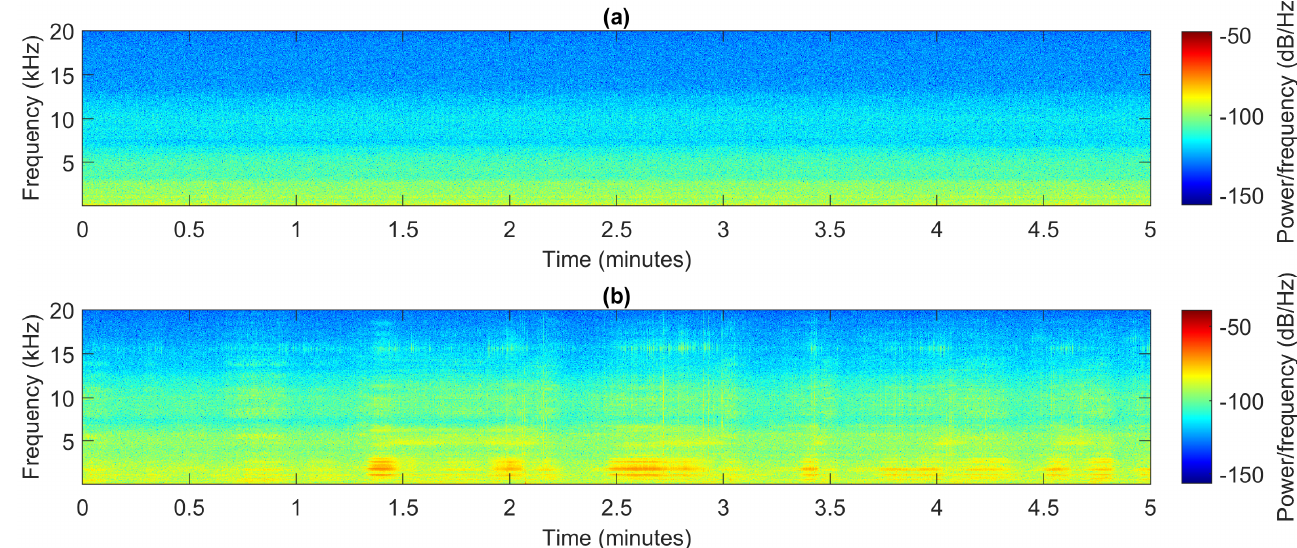
Figure 8. Spectrograms of the two signals: ( a ) No-Fault: the fan blades are perfectly clean and there are no accumulations of material on the surface; ( b ) Fault: there are deposits of artificially created material on the fan blades.